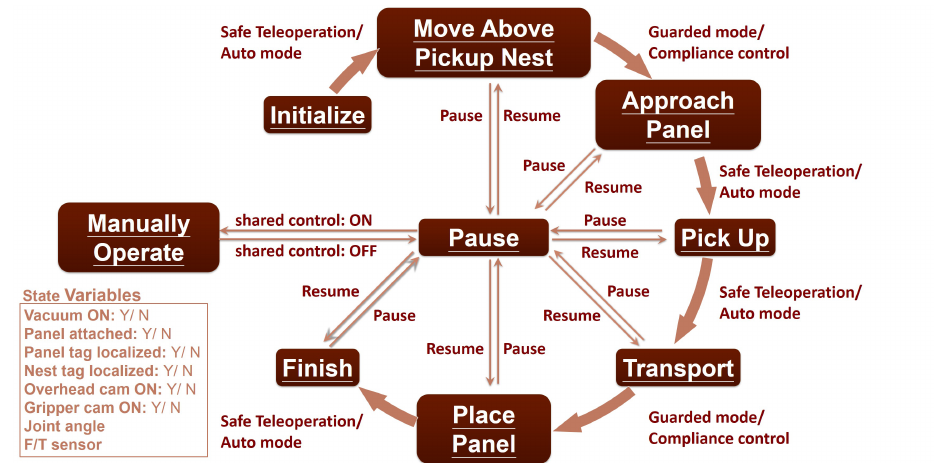
Figure 4. The state transition diagram of the assembly process allow continuous operation to assemble incoming panels to the existing panels. It also allows operator to pause for manual operations and resume after completion. The operator can also manually transition the system to a different state. The state of the system consists of the robot pose, sensor measurements, and end effector